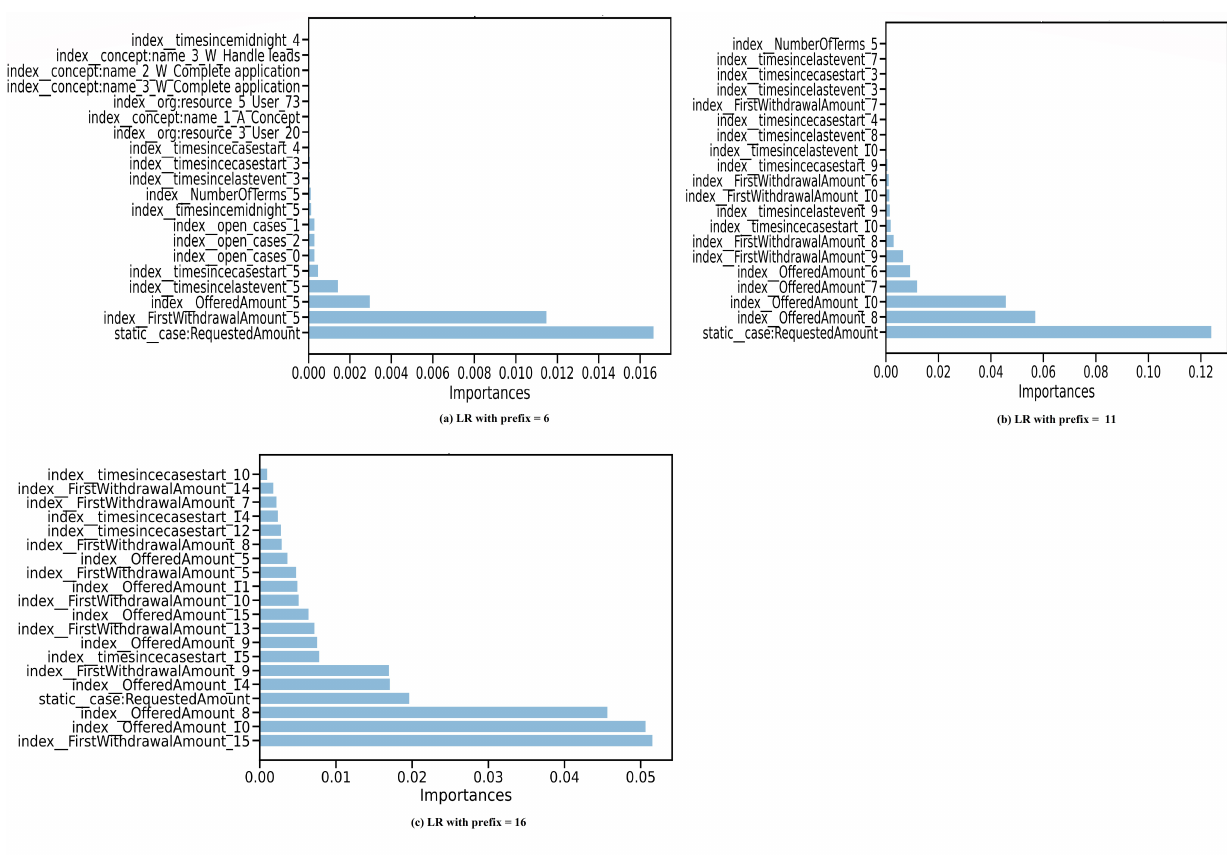
Figure 10. PFI according to LR trained over BPIC2017_Refused (preprocessed with prefix index